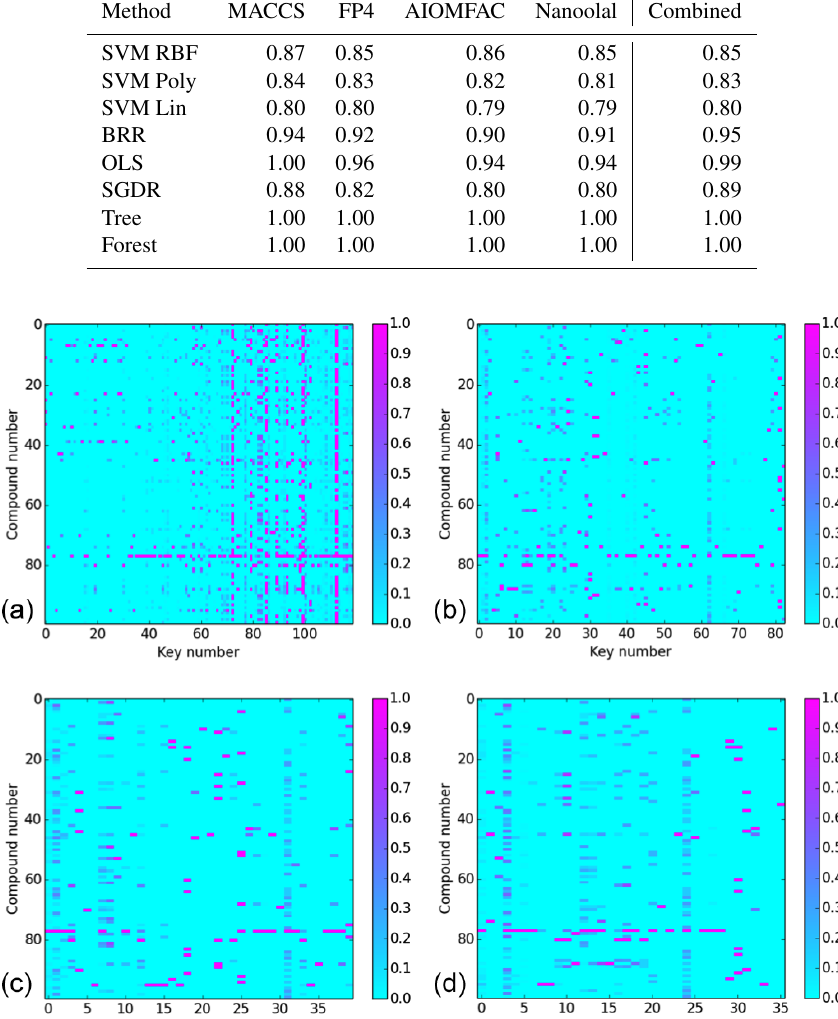
Figure 3. Sparsity of keys extracted ( x axes) from each compound ( y axes) as a function of the molecular fingerprint used ( a : MACCS; b : FP4; c : AIOMFAC; d : Nanoolal). Keys are coloured according to normalised stoichiometry across all